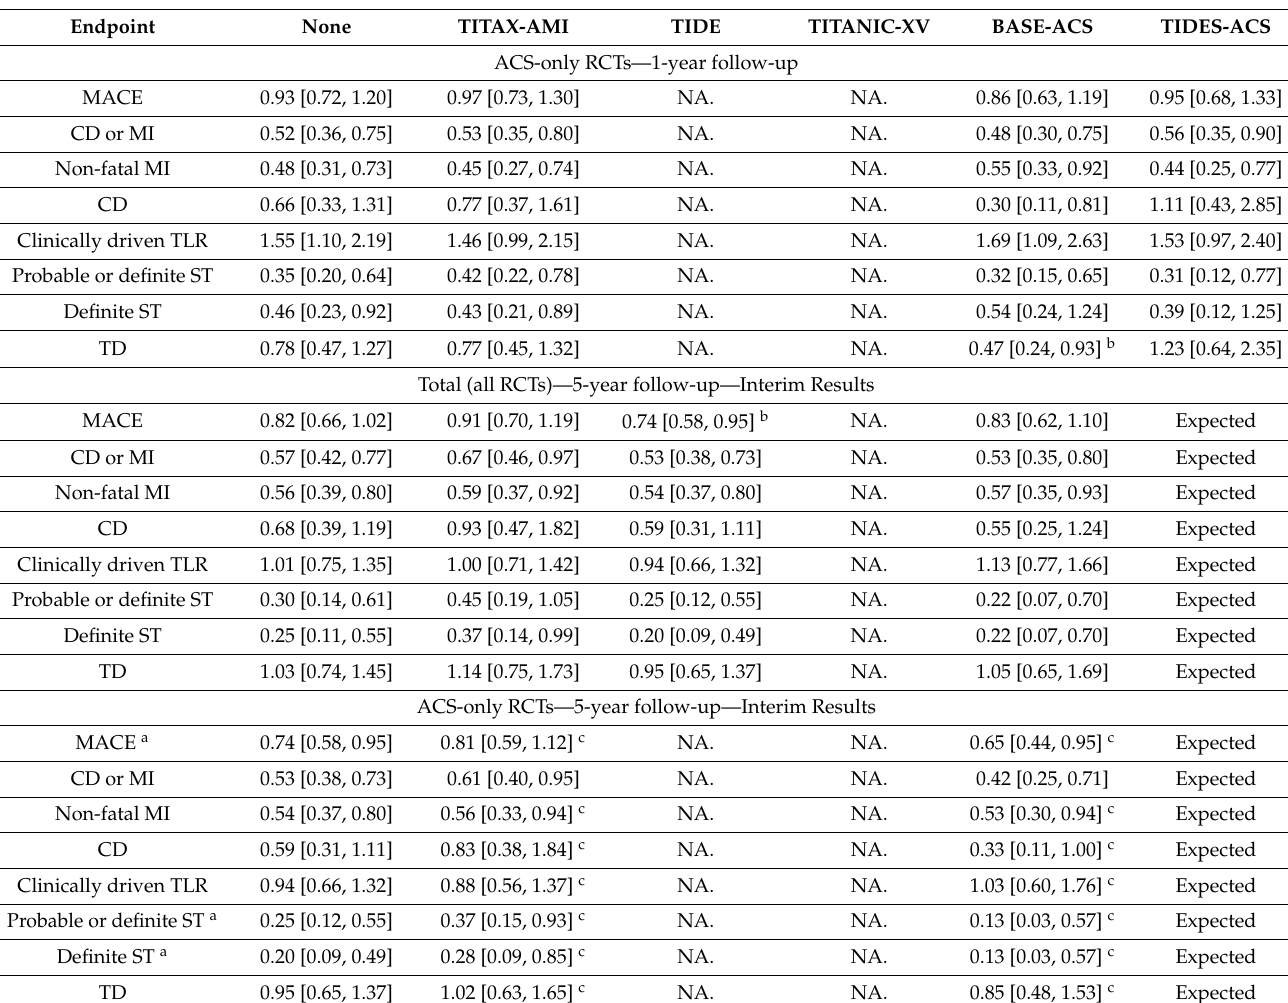
Table 2. Cont. M-H Fixed Effects RR and 95% CI after the Removal